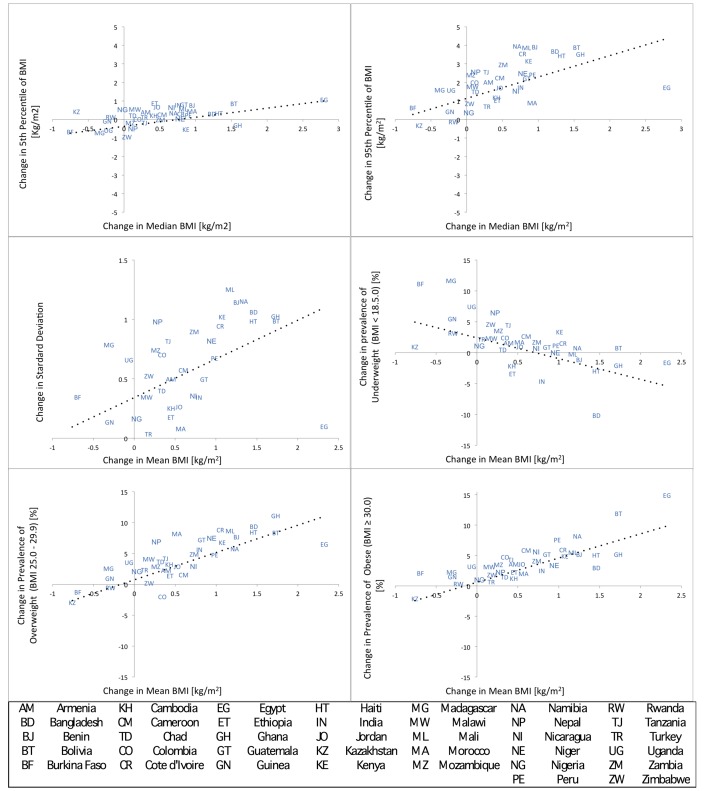
Change in specific parameters of the BMI distribution (5th and 95th percentile and SD) or categories of BMI (underweight, overweight, obese) versus change in mean or median BMI.Change is calculated from baseline survey to most recent survey and each data point is represented by a two-letter country code. Multilevel models across all country-survey cycles are contained in Table 2.